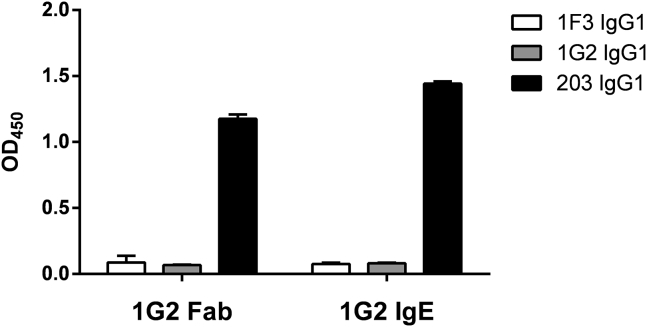
1G2 and 203 bind to distinct epitopes on SEE. Each well of a 96-well ELISA plate was coated with 1G2 Fab or IgE antibodies at 1 μg/mL (50 μL/well), followed by saturating 1G2 antibody binding sites with SEE at 1 μg/mL (100 μL/well). The 1F3, 1G2, and 203 IgG1 antibodies were added to each well, followed by incubation with peroxidase-conjugated goat anti-human IgG/Fc.